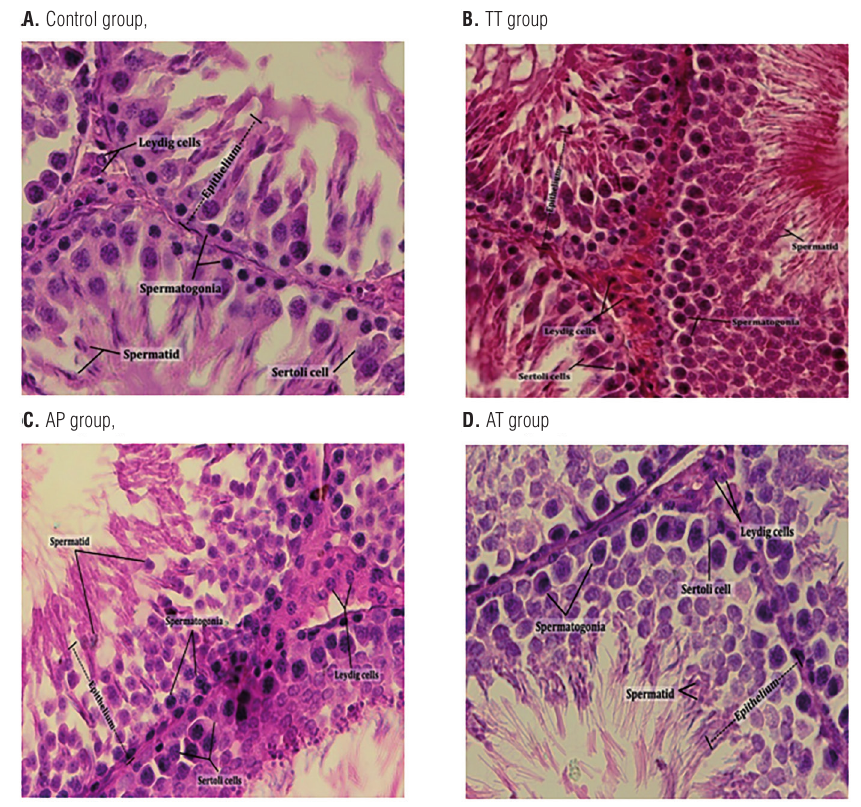
Figure 5 - Comparative H&E staining of seminiferous epithelium demonstrated increased thickness and Leydig, Sertoli, spermatid and spermatogonia cell numbers in AT